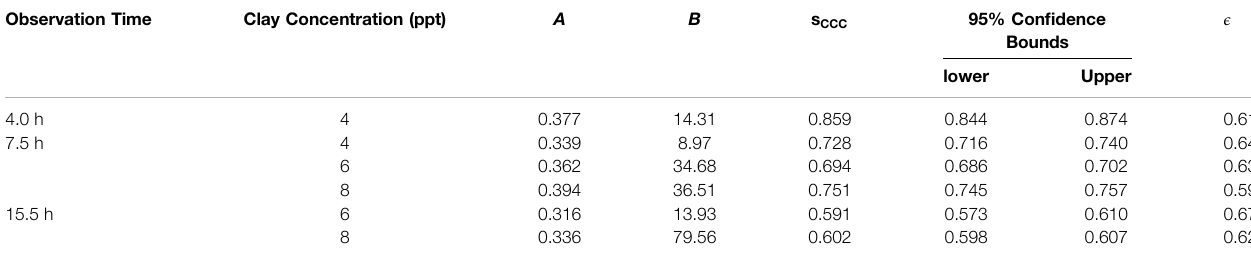
TABLE 2 | Summary of the parameter fi ts using Eq. 7 for the data in Figure 6 . Observation Time Clay Concentration